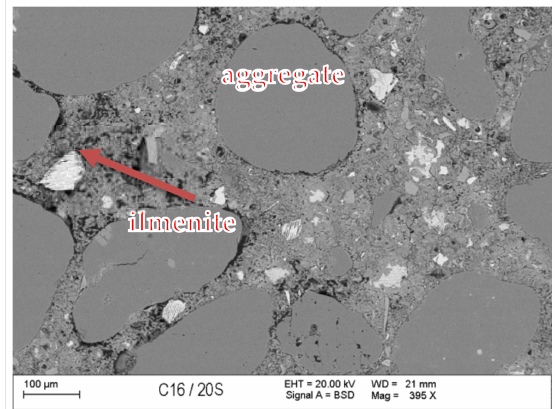
Figure 11. BSE image of RMUD concrete sample.